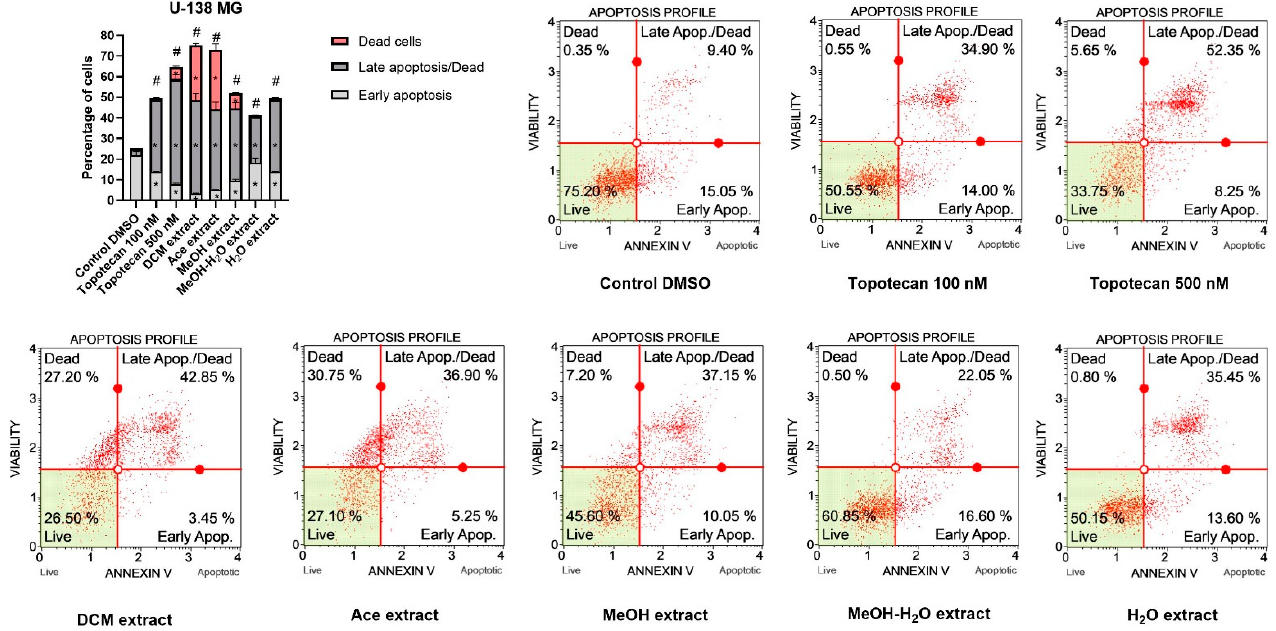
Figure 8. Apoptosis profiles of U-138 MG cells as studied by the Muse™ Annexin V & Dead Cell Kit after 48 h of treatment. Values on the bar chart are shown as mean ± SEM calculated from two independent experiments. (*) indicates statistically significant differences from control group for dead, late apoptosis/dead or early apoptosis cells; (#) above bar indicates statistically significant differences from control group for total apoptotic/dead cells, p < 0.05. Representative histograms of controls (DMSO—negative control, topotecan—positive control) and analysed P. glauca ex-tracts are also presented. Each histogram has four quadrant markers, reflecting the different cellular states: the upper left quadrant contains dead cells (necrosis), the upper right has late apoptotic/dead cells (cells that are positive both for Annexin V and for 7-aminoactinomycin D), the low-er left contains live cells and the lower right early apoptotic cells (cells that are positive only for Annexin V).